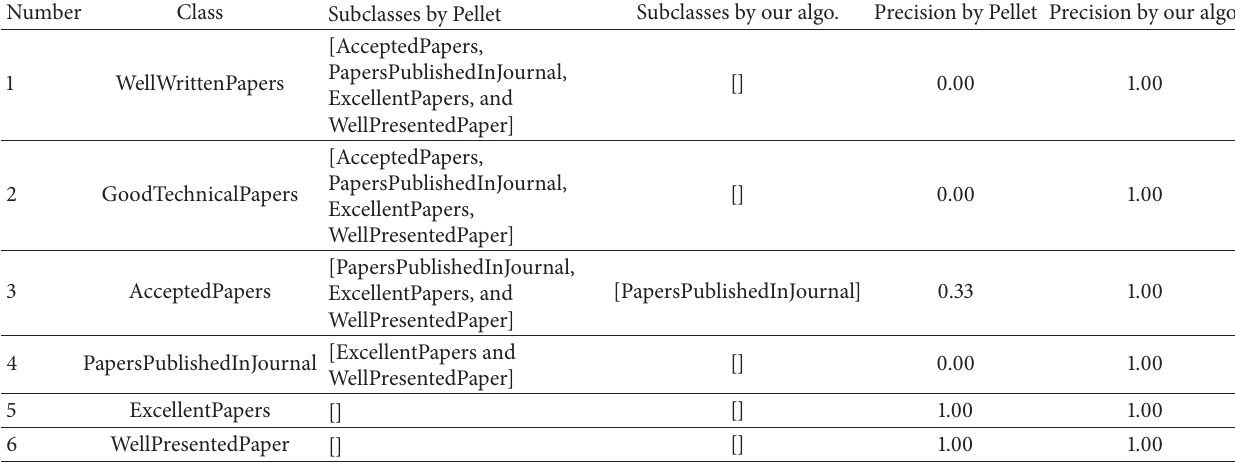
Table 9: Conference cases subclass calculation results: